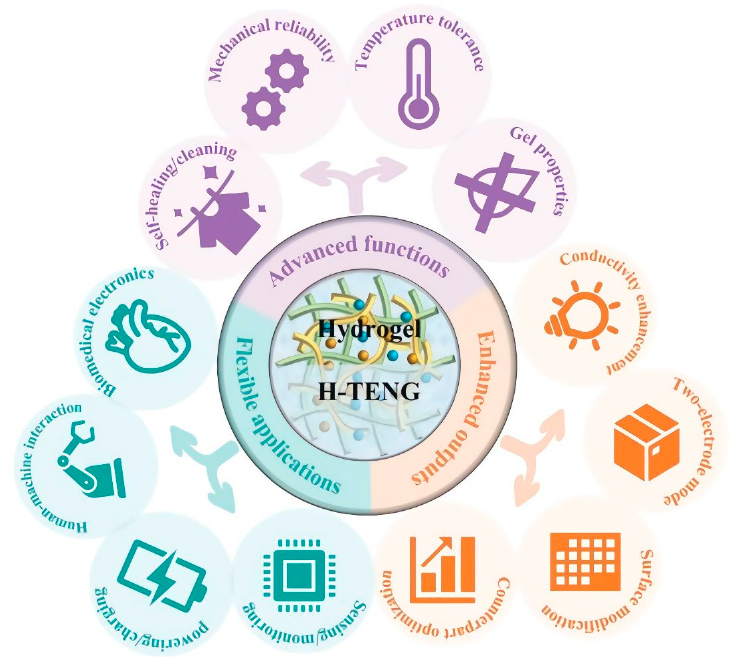
Figure 9. Development of H-TENGs: advanced functions, enhanced outputs, and flexible and wearable applications. Reprinted from Ref. [121] with permission.